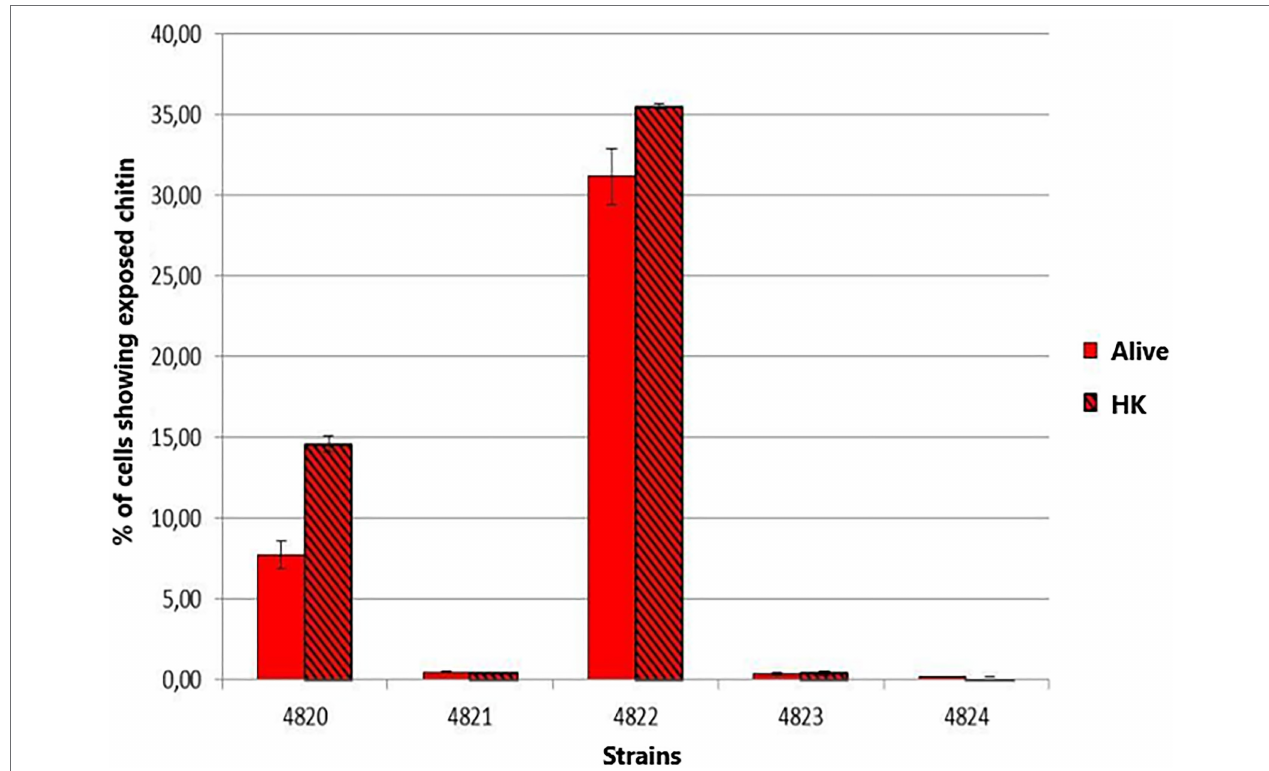
FIGURE 8 | Comparison of the chitin exposure on the yeast cells of S. schenckii and S. brasiliensis grown in Brain Heart Infusion (BHI) broth. The smooth bars represent the exposure of chitin under normal and live cell (Alive). The bars with frames represent the percentage of exposed chitin after the cells were heat inactivated